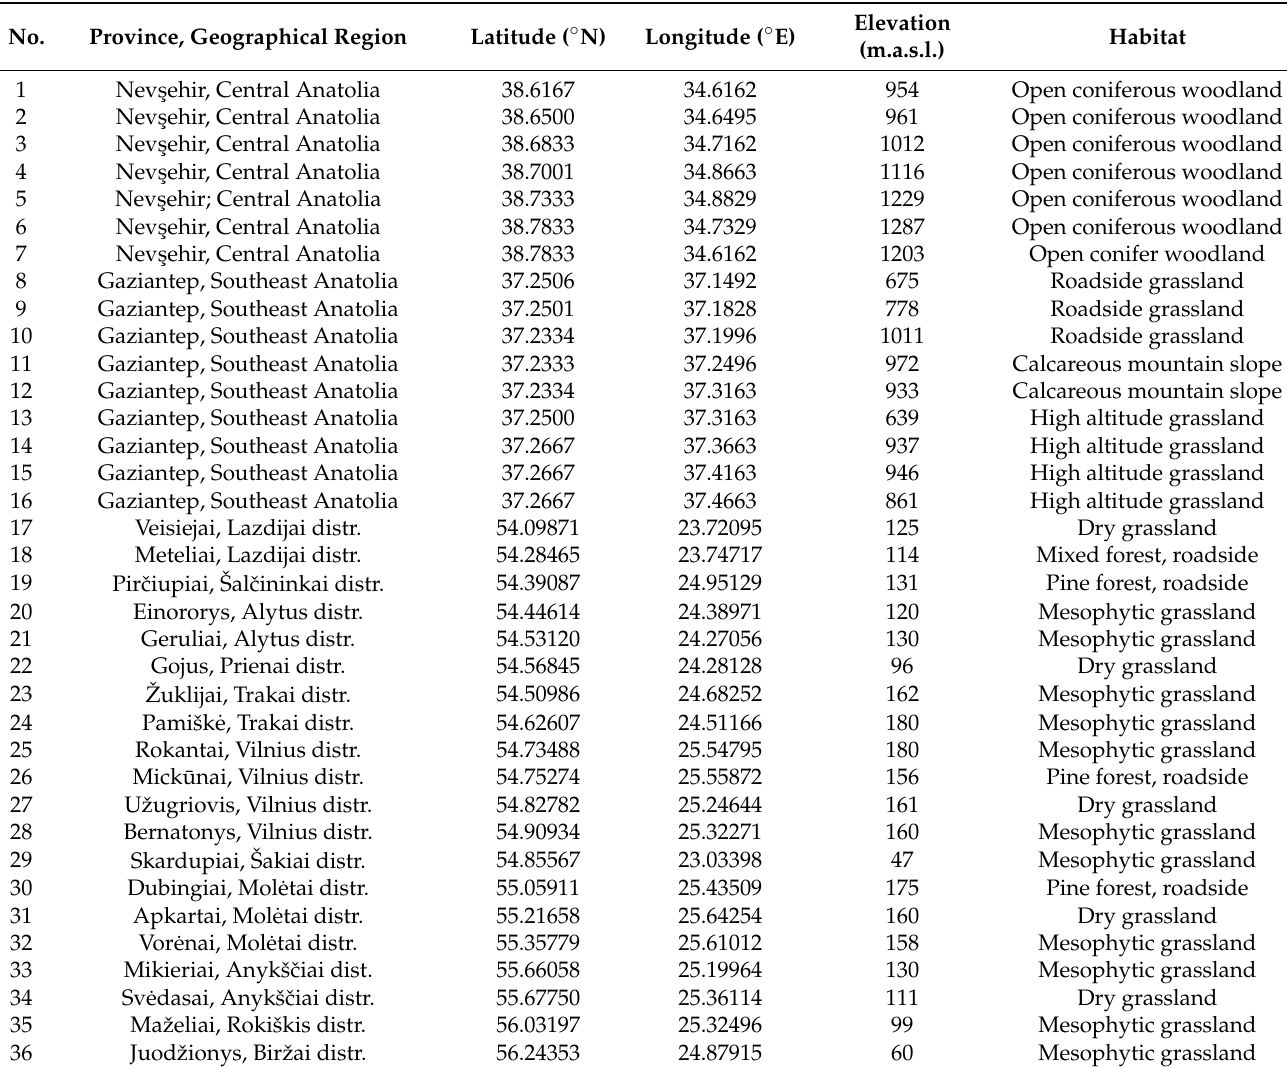
Table 6. Sampling sites, coordinates, elevation, and habitats of Achillea millefolium populations from Turkey and